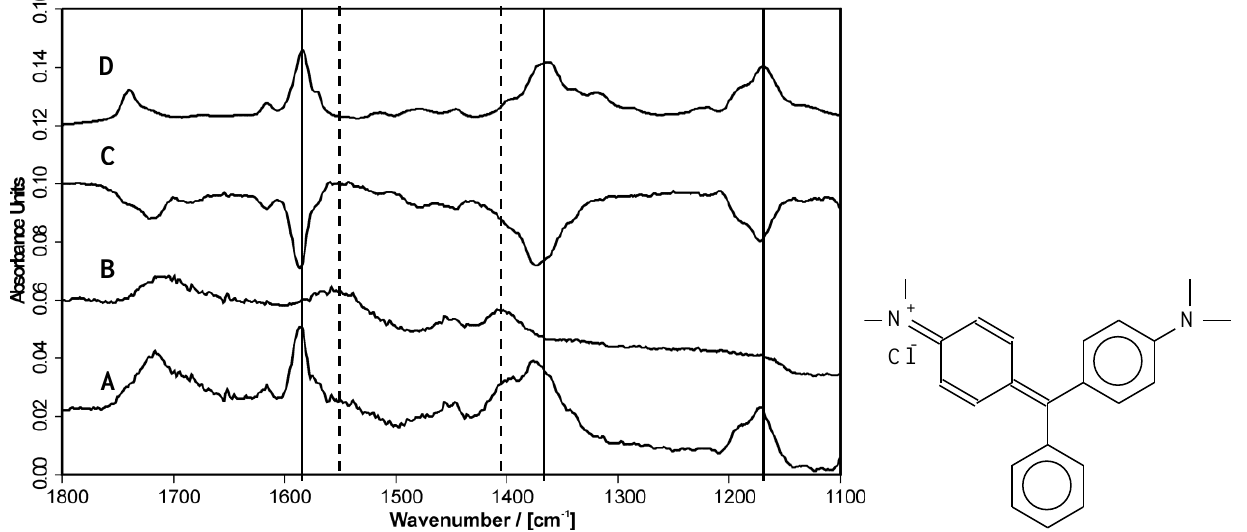
Figure 15. ATR-FTIR spectra of solution casted dry PEC-0.8 films of PEI/PAC (n /n = 0.8, cationic) ( A ) loaded with malachite green (MLG); ( B ) after contact to H + − for 15 h; ( C ) difference (B) minus (A); ( D ) pure MLG film. IR bands of MLG are labeled by full lines and of PEI/PAC by broken lines. The structure of MLG is given on the